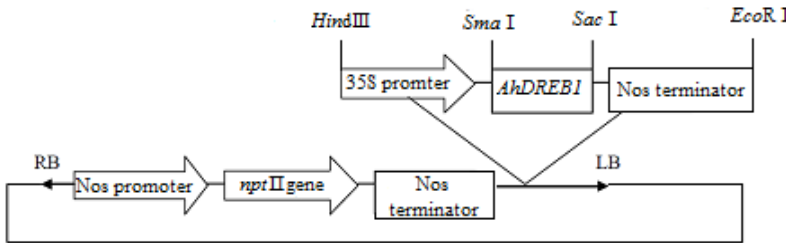
Figure 1. Structural drawing of AhDREB 1 in the Ti expression